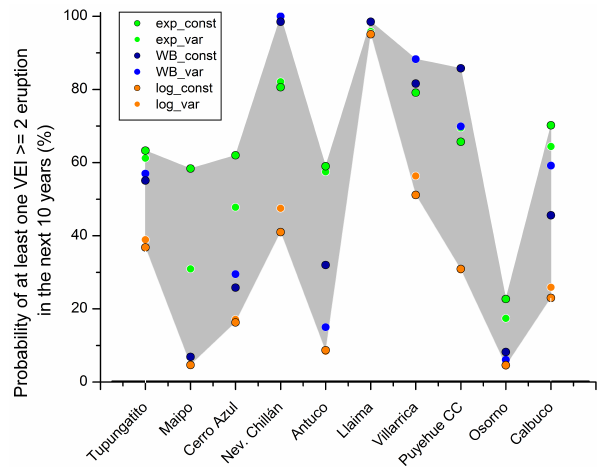
Fig. 7. Baseline of typical volcanic activity of the historically fre- quently active volcanoes of the SVZ, expressed as probability (in %) of at least one VEI ≥ 2 eruption in the next ten years. Volcanoes are ordered from North to South. The shaded area is approximated between the volcanoes for better